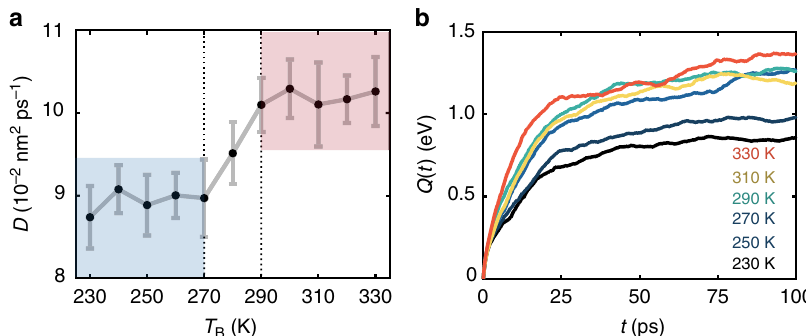
Fig. 2 Benchmarks for thermal transport. a Heat diffusivity D along the major axis of helical Aib 10 at increasing bath temperatures T B . Diffusivities are derived from the time t max to reach the maximal temperature at each residue following a model t max = d 2 / D , where d is the distance from the heater site. Colored regions denote low – (blue) and high – temperature (red) regimes (error bars are plus/minus one standard error). b Net heat Q ( t ) transferred from residue two to three versus simulation time and bath temperature, following the scheme of Eq. (1). Error bands for the maximal cumulative integration error, as well as net heat transfer between other residues, are in Supplementary Figs. 1